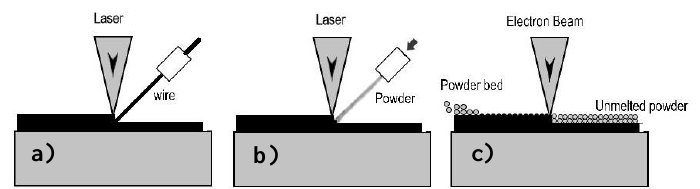
Figure 1. Schematic representation of metal additive manufacturing (AM) processes used: ( a ) laser wire melting with wire feeding system; ( b ) laser metal deposition system; ( c ) powder bed fusion with electron beam melting.